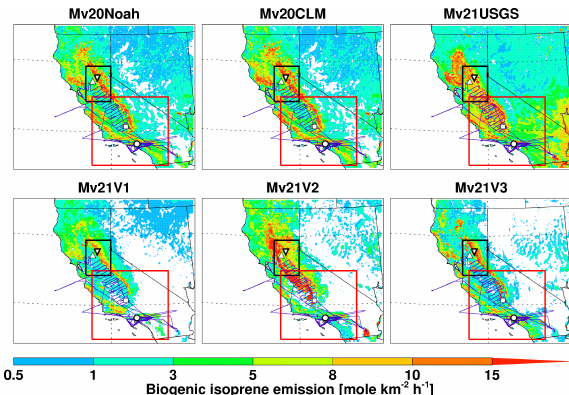
Figure 7. Spatial distributions of biogenic isoprene emissions av- eraged in June estimated in the six simulations as listed in Table 2. The four observation sites are shown as T0 (white upward trian- gle), T1 (white downward triangle), Bakersfield (white square) and Pasadena (white circle). The CalNex WP-3D flight tracks below 1km (blue line) during June 2010 are also shown. The black and red boxes denote the predominant CARES and CalNex regions, re-